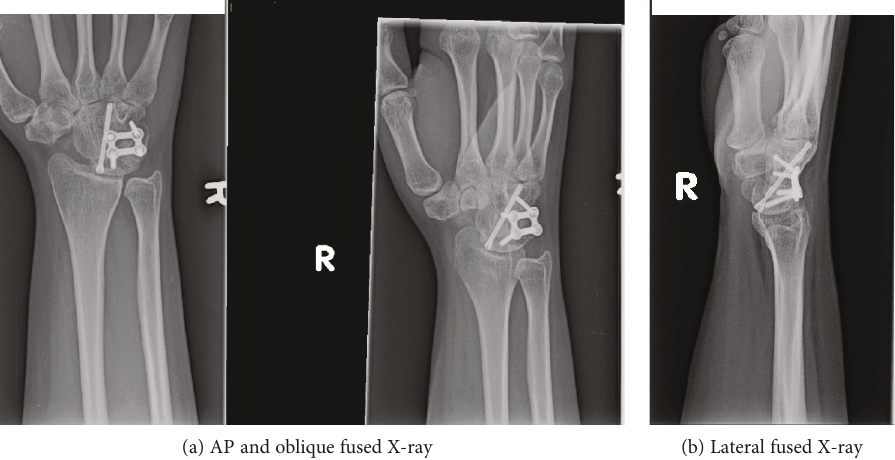
Figure 6: (a, b) AP and oblique (a) and lateral (6) radiographs of the right wrist, demonstrating consolidated 4-bone carpal